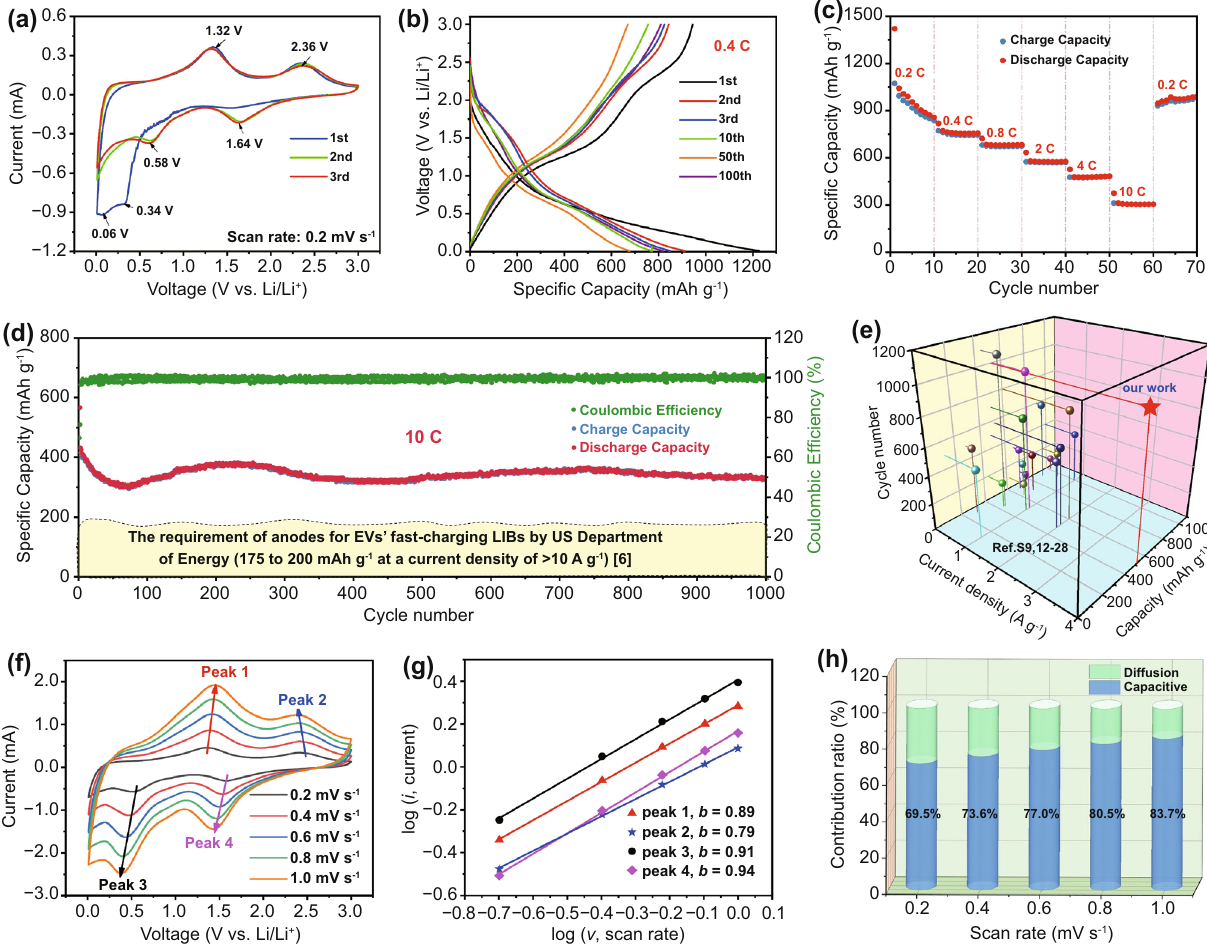
Fig. 4 Electrochemical properties of PCVO ND. a CV curves. b Galvanostatic discharge and charge curves at 0.4 C. c Rate performance. d Cycling performance at 10 C. e A comparison of electrochemical properties. f CV curves at different scan rates. g Log( i ) versus log( v ) plots at specific peaks. h Contribution ratio of the capacitive and diffusion-controlled capacities at various scan rates (1 C=1000 mA g −1